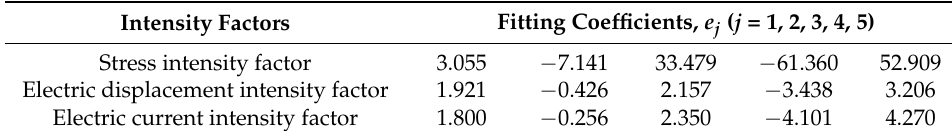
Table 2. Fitting coefficients ( e j in Equation (16)) under the different types of intensity